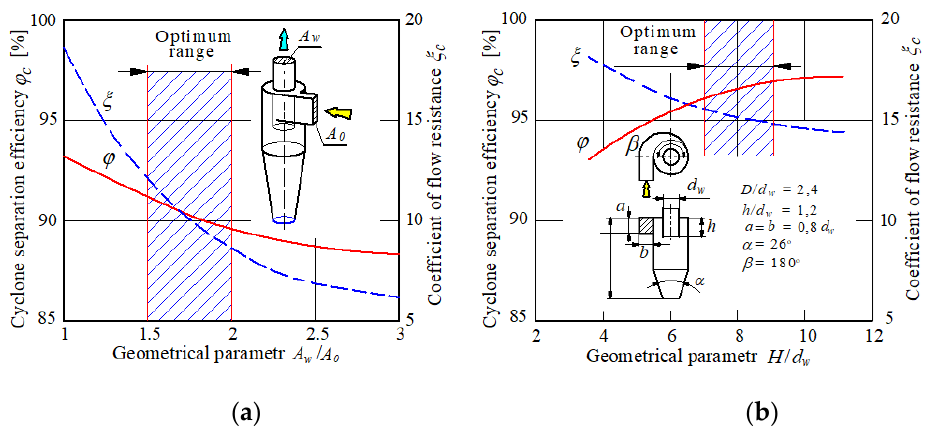
Figure 7. Separation efficiency ϕ c and coefficient of pressure drop ξ c of cyclones as a function of: ( a ) A w/ A 0 and ( b ) H/d w parameter. Figure made by author based on data from paper [39].